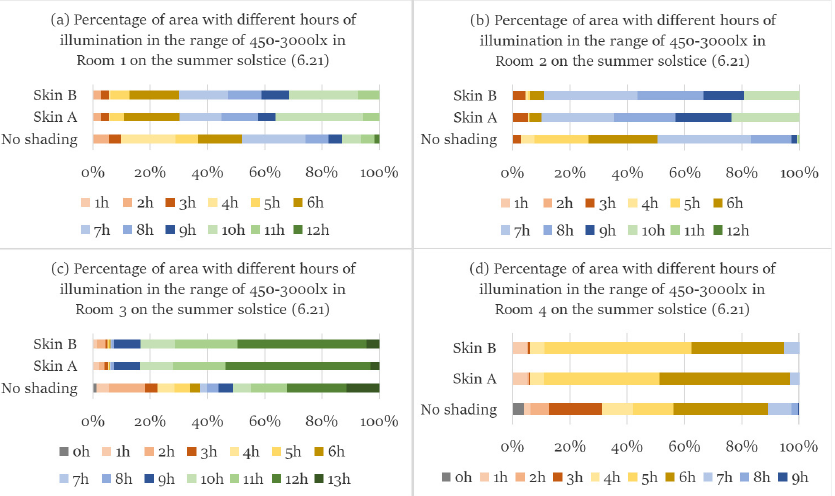
Figure 17. Percentage of the area with different hours of illumination in the range of 450–3000l× in ( a ) Room 1, ( b ) Room 2, ( c ) Room 3, and ( d ) Room 4 on the summer solstice (6.21) (self-developed).